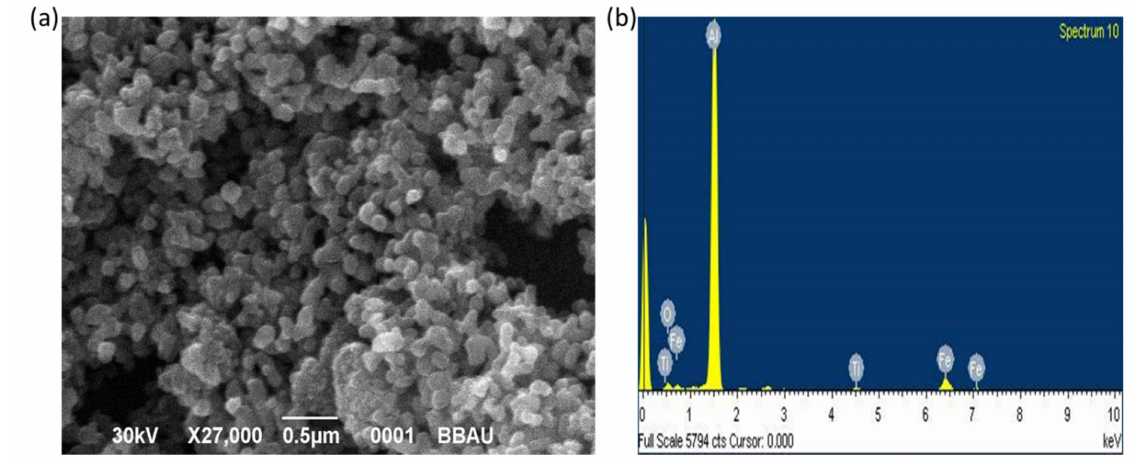
Figure 4. ( a ) Scanning electron microscopic image and ( b ) EDS spectrum of CP-01-200 nanopowder. A strong EDS peak of Al is from the Al coated carbon